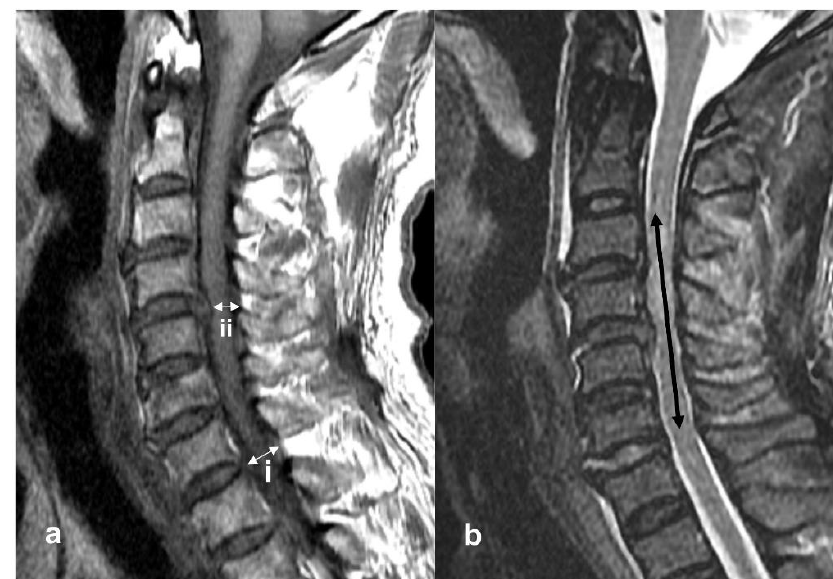
Figure 1. Sagittal magnetic resonance imagery (MRI) obtained in a 69-year-old man who presented with severe adult spinal cord injury without major bone injury and American Spinal Injury Association Impairment Scale (AIS) grade A. ( a ) T1-weighted image. ( i ) The diameter of the cervical cord at the non-compression level. (ii) The diameter of the cervical cord at the injured level. Compression rate was calculated by the equation. Compression rate was 35.2%. ( b ) T2-weighted image at C3-4-5-6 showed the signal change, and the rostrocaudal length of damage was measured in millimeters. Intramedullary lesion length (IMLL) was 62 mm.